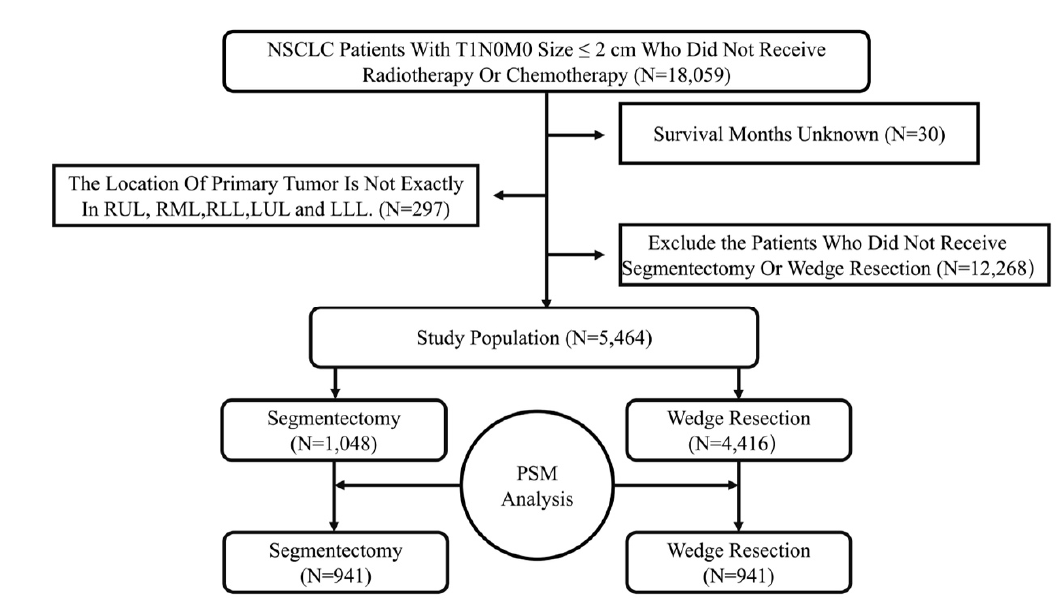
Figure 1. Selection of eligible patients. Table 1. Baseline characteristics of NSCLC patients with size ≤ 2